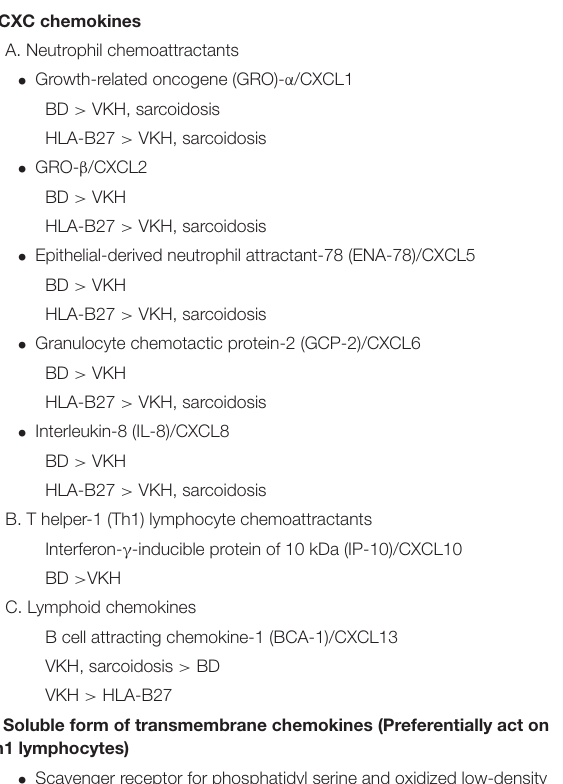
TABLE 1 | Summary of pairwise comparisons between disease